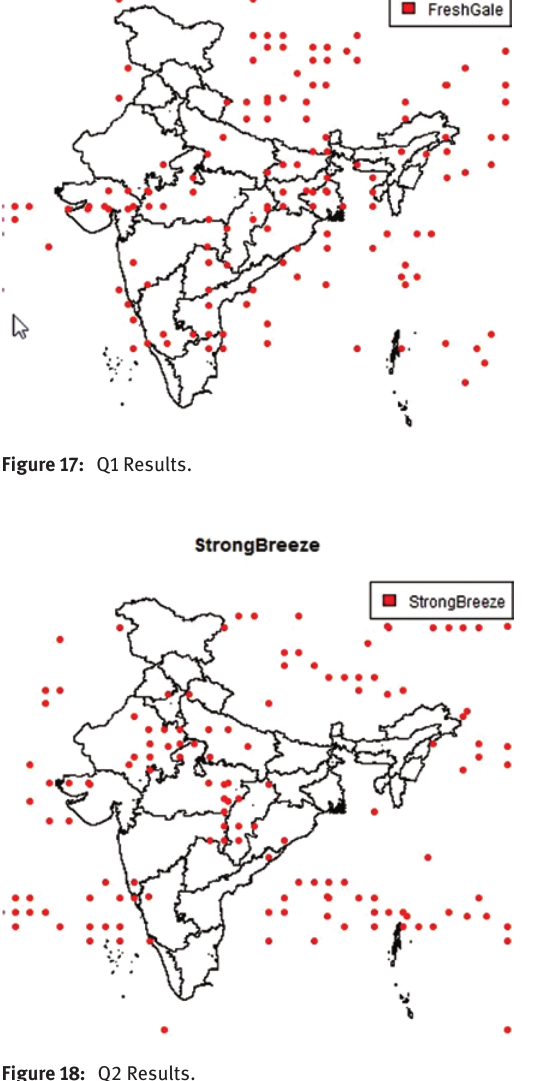
Figure 18: Q2 Results.